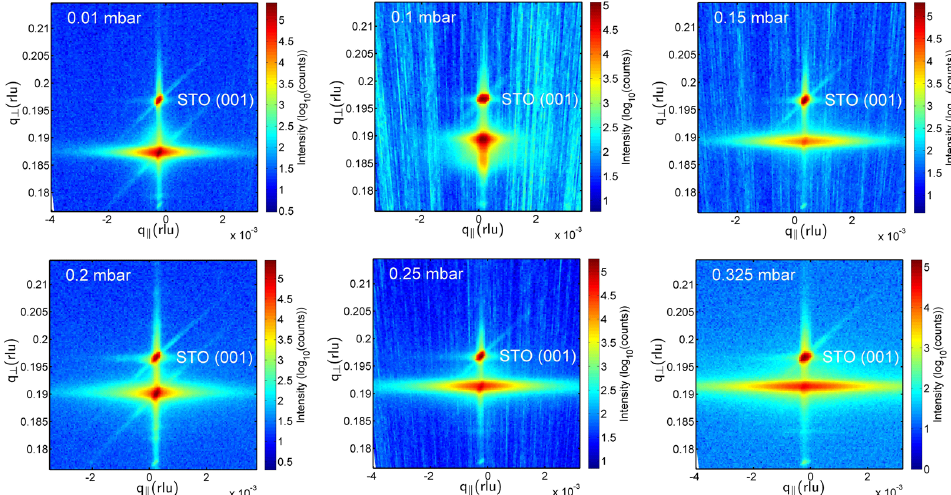
Figure 2. XRD reciprocal space maps around the symmetric SrTiO 3 001 peaks of BaTiO 3 (67 wt %) ‐ BiFeO 3 (33 wt %) composite thin films grown at the indicated PLD oxygen partial pressures. The separation of a point ‐ like substrate and a broadened composite film peak decreases with increasing oxygen partial pressure due to decreasing out ‐ of ‐ plane strain; see Table 1. The horizontal broadening of film peaks is a measure of the tilt mosaicity of the composites. STO stands for SrTiO 3 . As the lattice parameters of BaTiO 3 and BiFeO 3 as bulk and thin films are very close together (see the Joint Committee on Powder Diffraction Standards (JCPDS) data in the caption of Table 1), the XRD peaks of the BaTiO 3 and BiFeO 3 phases in our composites cannot be resolved. Even closer agreement of BaTiO 3 and BiFeO 3 lattice parameters is supported by [26], reporting for BiFeO 3 in tetragonal P 4 mm symmetry a = 0.3935 and c = 0.3998 nm. Therefore, we assume an averaged 4/13